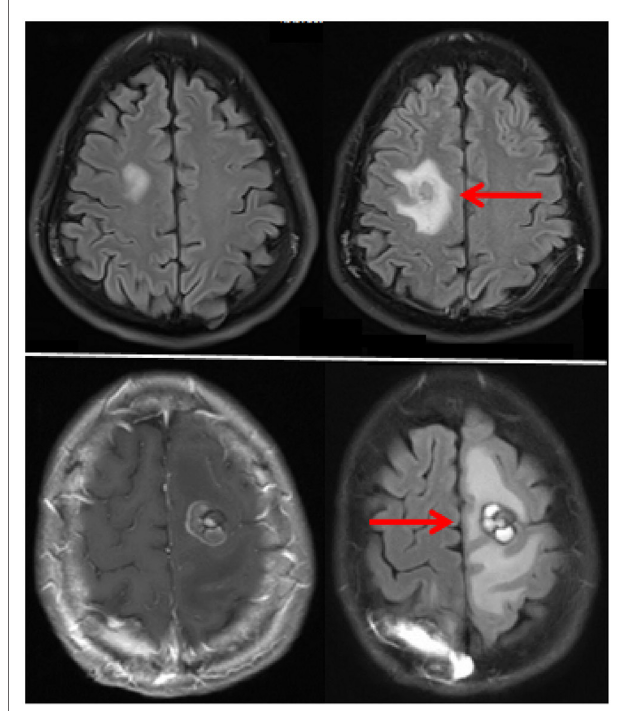
FiGURE 1 | MRi FLAiR images of two patients with perilesional while receiving pembrolizumab . The top and bottom frames represent the two separate patients. Images prior to therapy are on the left and after therapy on the